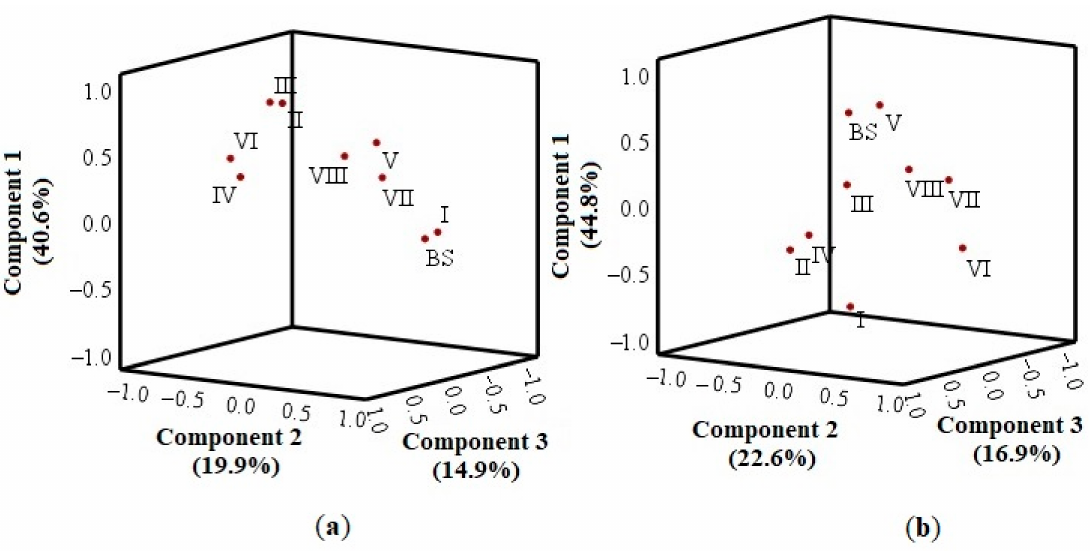
Figure 10. Analysis of the principal components of the antioxidant activity: ( a ) The principal compo- nents of the antioxidant activity of the whole apple stored under controlled atmospheric conditions; ( b ) The principal components of the antioxidant activity of apple peel stored under controlled atmo- spheric